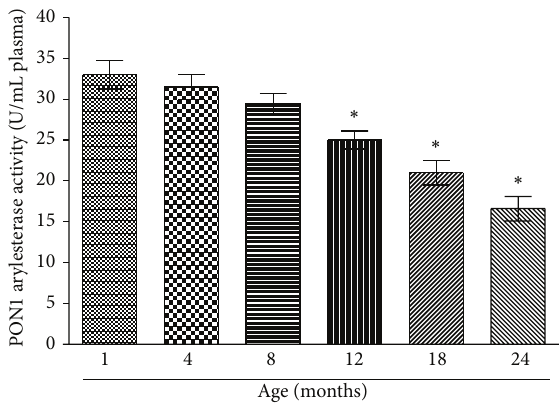
Figure 1: Plasma paraoxonase 1 (PON1) arylesterase activity as a function of rat age. PON1 activity is expressed as U/mL plasma. Values are mean ± SEM. ∗ 𝑃 < 0.001 compared to control (1-month- old